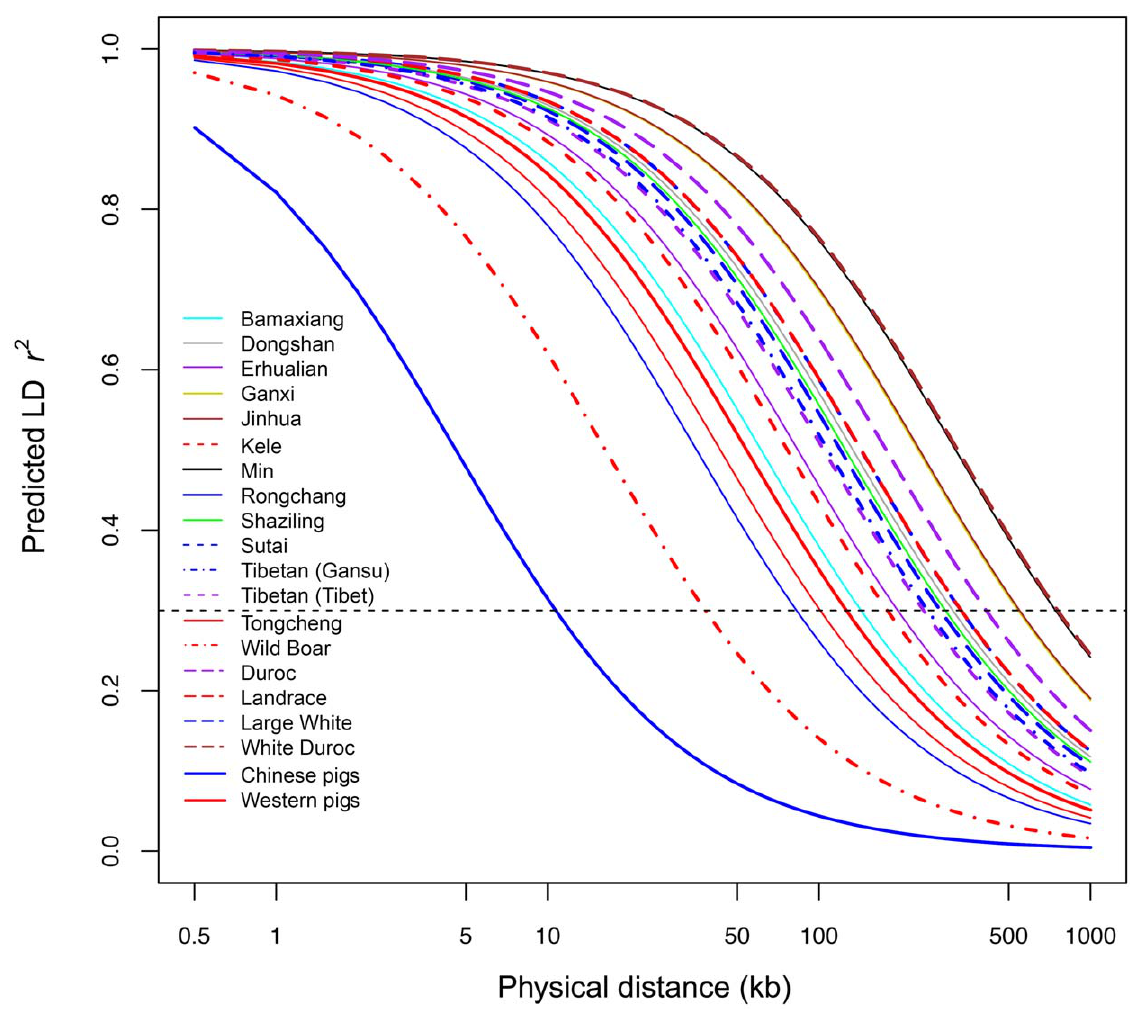
Figure 4. Extent of LD (predicted r 2 ) as a function of inter-SNP distance between Chinese and Western pigs and within each population.